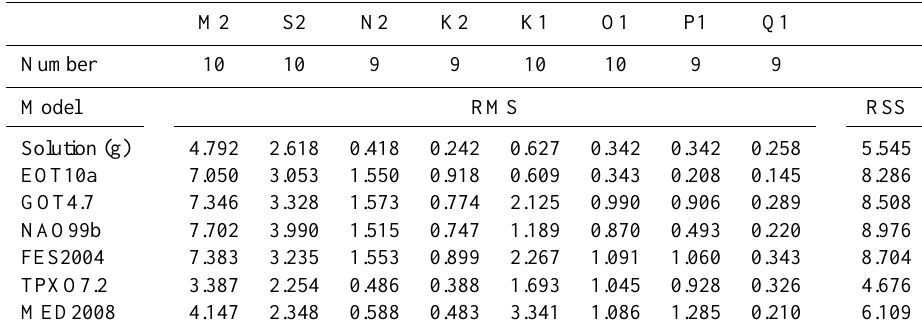
Table12. RMS and RSS ofthedifferencesbetweentheconstituentsoftheempiricalmodelEOT10aatcrossoversoverMediterranean, andothercontemporaryglobalandregionaltidemodels.Unitiscm. Table 11. RMS and RSS misfit between the observed 76 and corresponding MEDI10 amplitude and phases. Unit iscm.